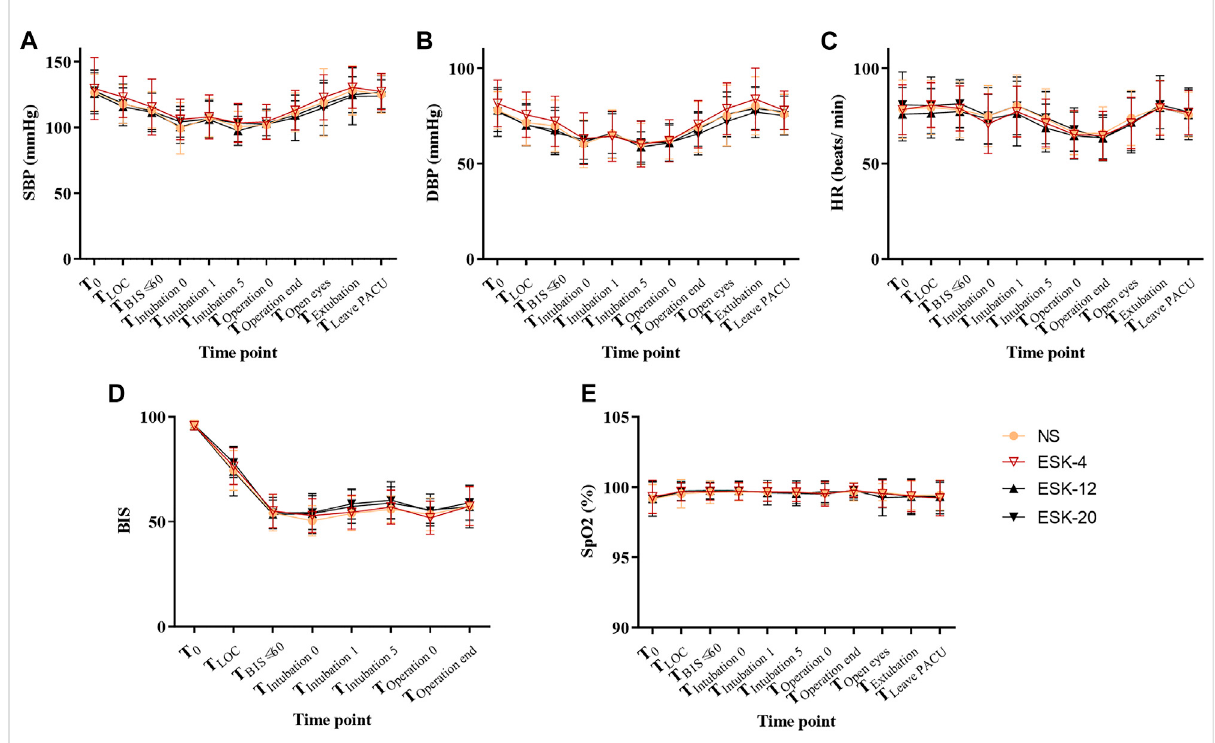
FIGURE 2 Changes in vital signs of patients. A – E : No statistically signi fi cant differences were observed between the groups. Abbreviations: SBP, systolic blood pressure; DBP, diastolic blood pressure; HR, heart rate; SPO 2 , pulse oximetry; NS, normal saline; ESK, esketamine; BIS, bispectral